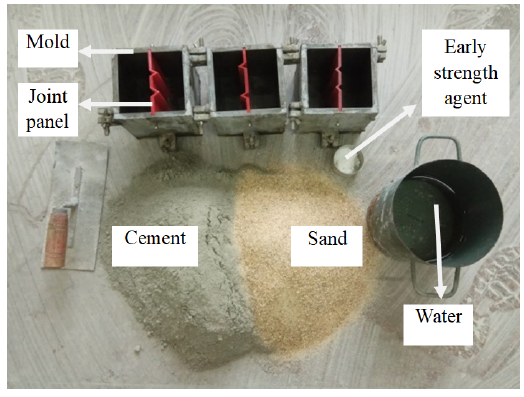
Figure 3: Production material of rock joint specimen